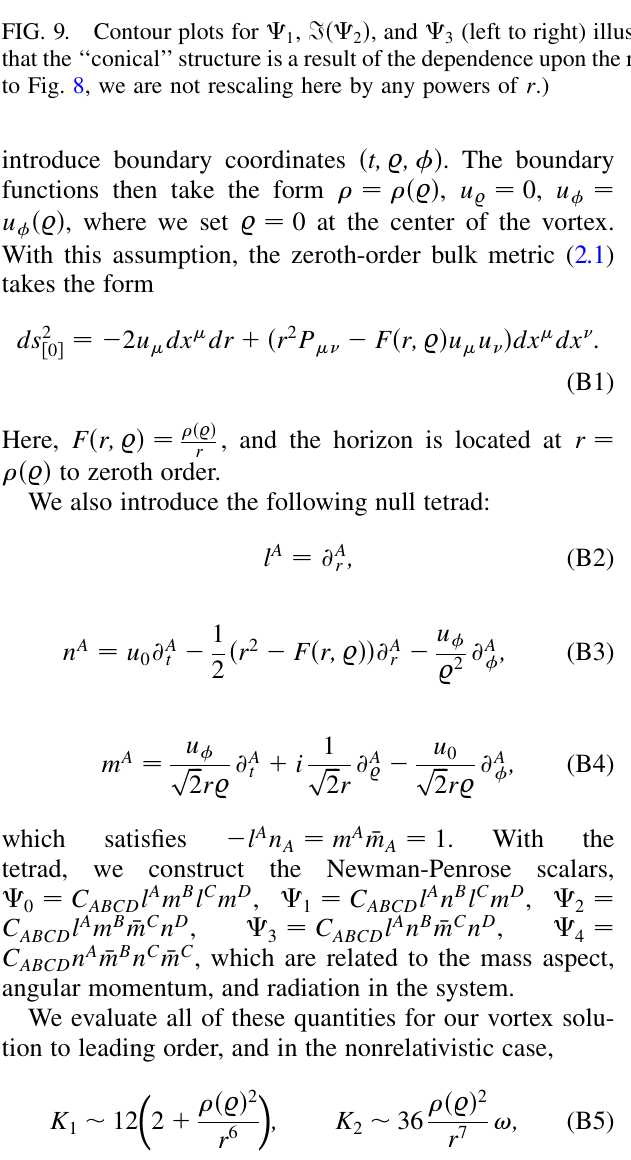
Þ(cid:4) 2 [49] ( labeled Z , Z , and 2 1 2